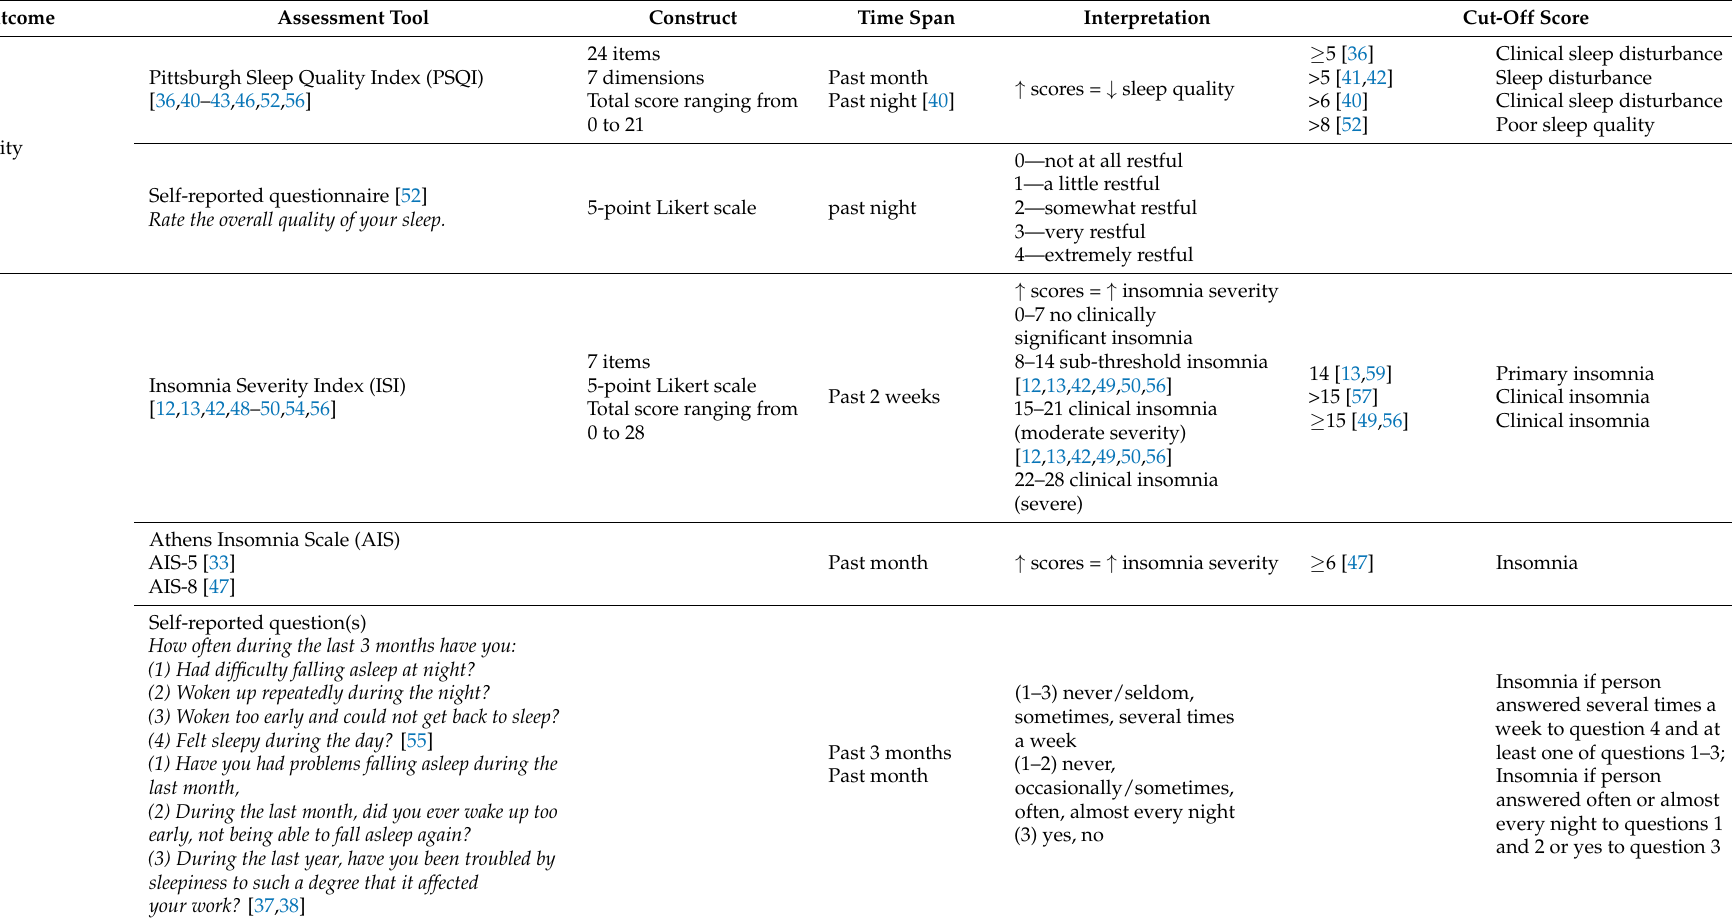
Table 8. Overview of the details of the used sleep